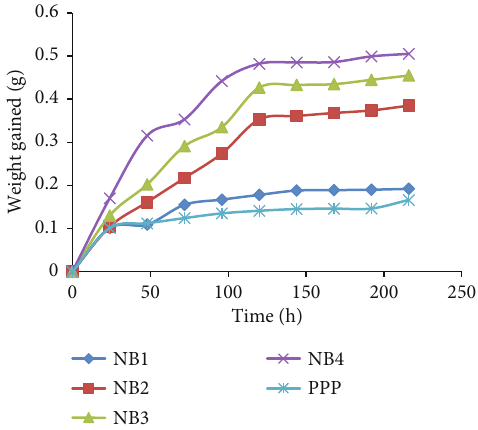
Figure 10: Water absorption tests for NaOH-treated composites and the pure PP.